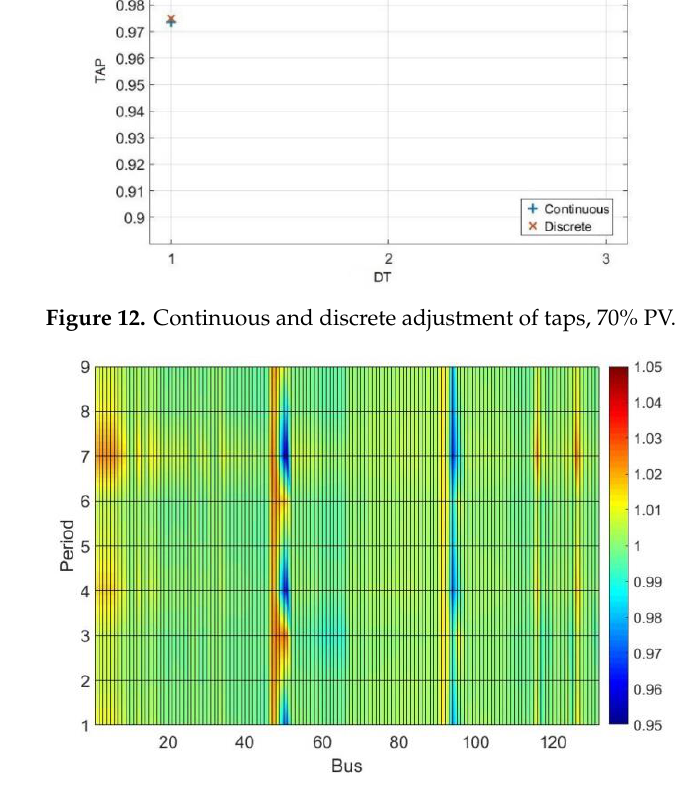
Figure 13. IEEE 123-bus system, voltage magnitudes of phase A, continuous taps, 70% PV.